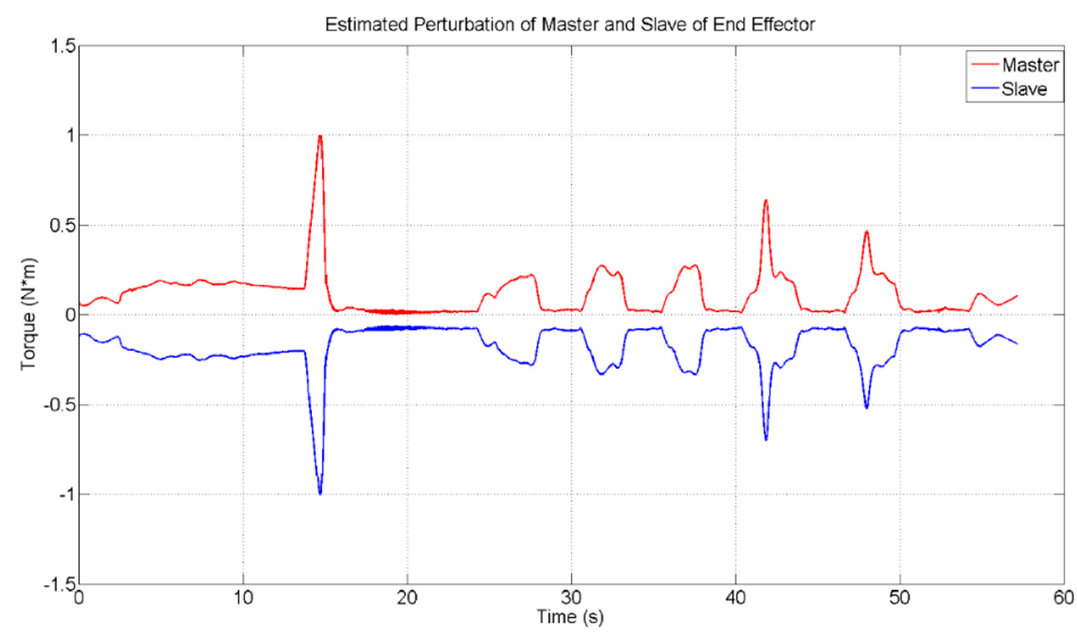
Figure 15. Normalized estimated perturbation of master and slave for end effector.